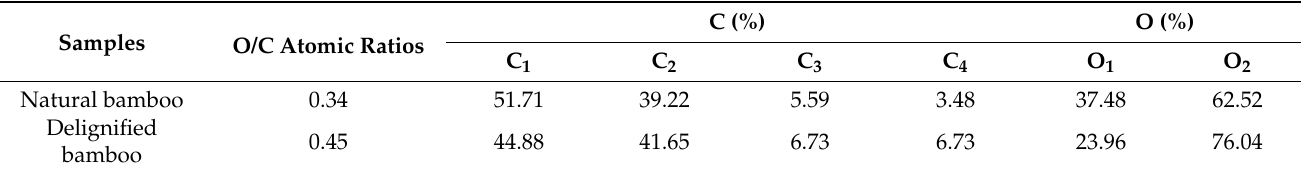
Table 3. Summary of XPS spectral parameters of NB and